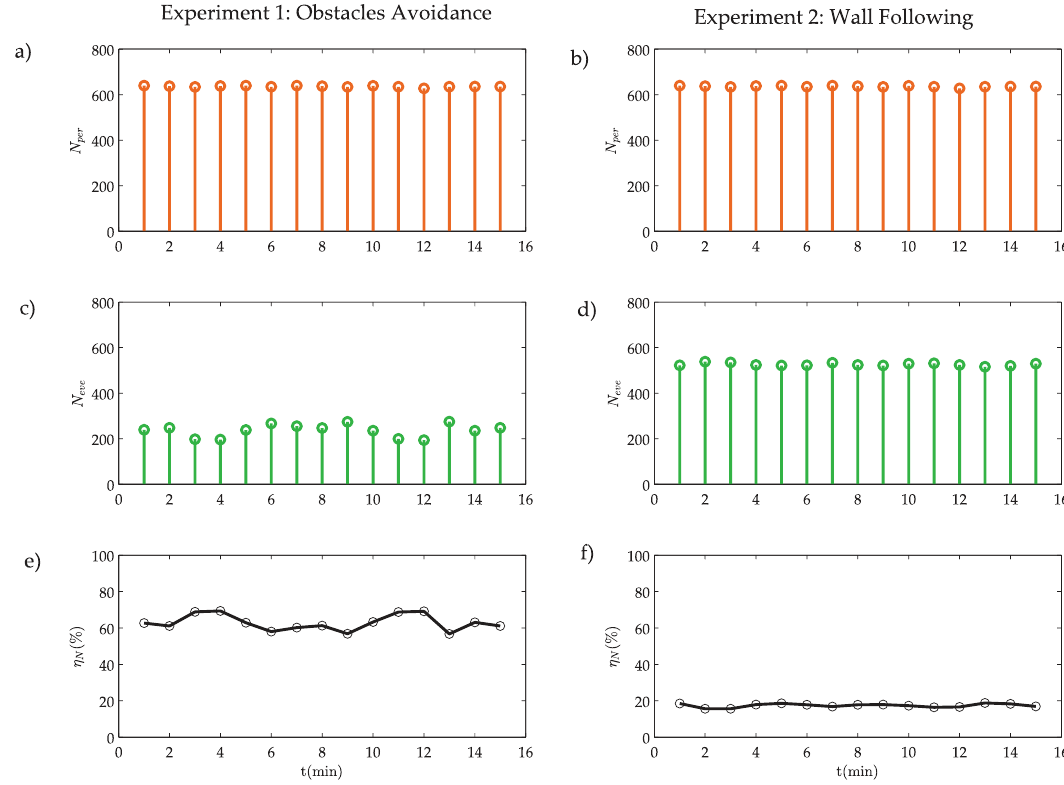
Figure 14. Activity of the systems: number of samples N per ( a , b ); number of events N eve ( c , d ); and event efficiency η N ( e , f ).